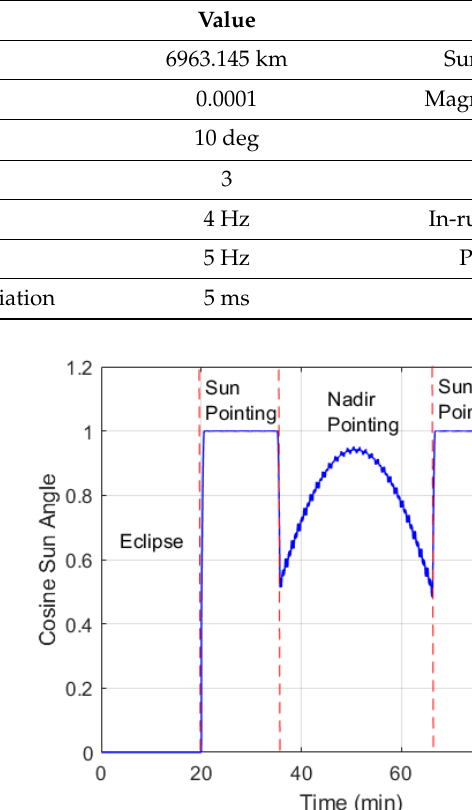
Table 2. Simulation Configuration.